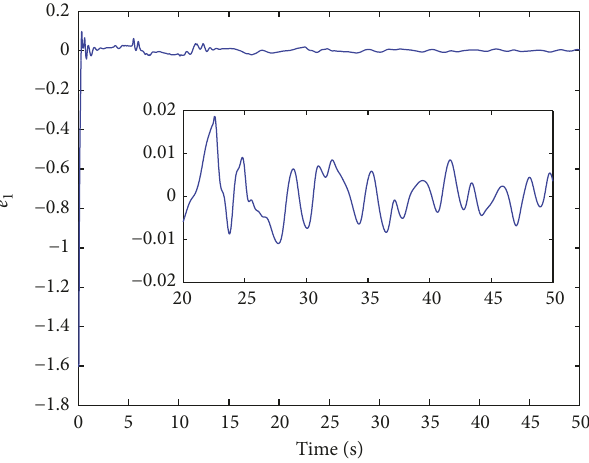
Figure 9: Trajectory of tracking error 𝑒 1 (𝑡) .